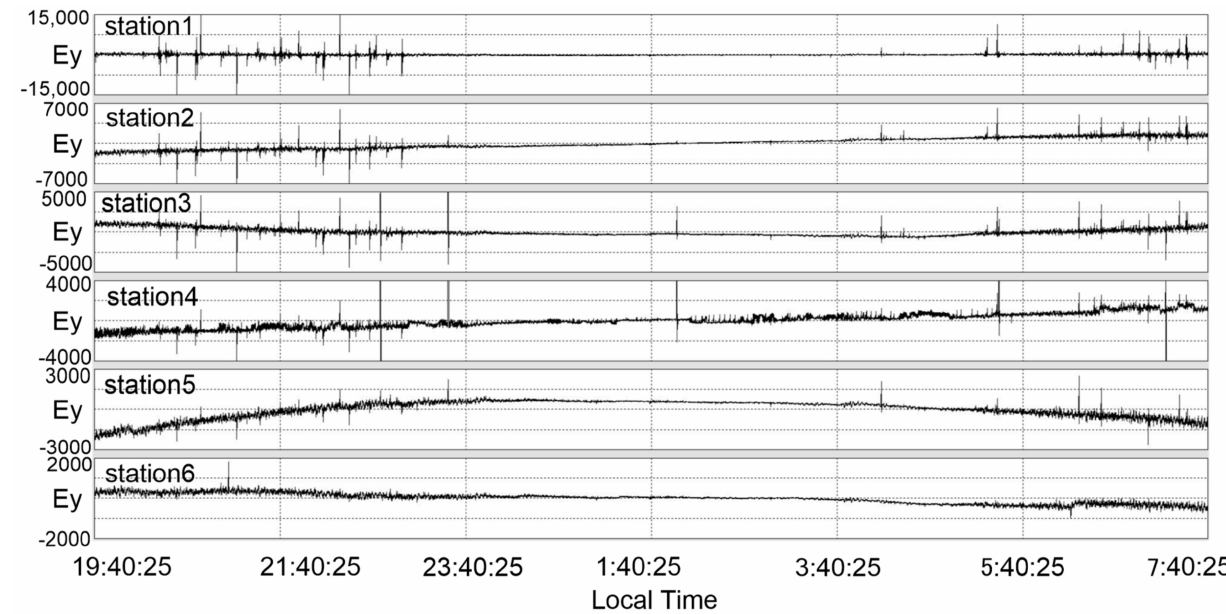
Figure 3. The 4 min time series of 5 components from station 2.